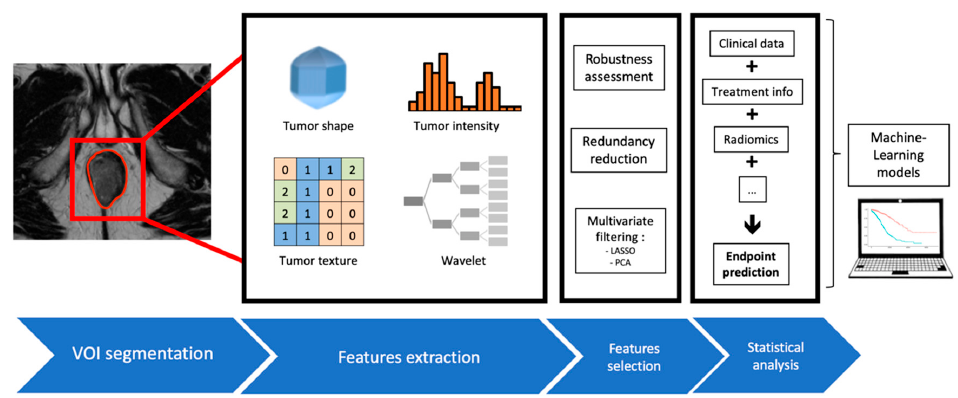
Figure 1. Radiomics workflow and integration into Machine Learning models.